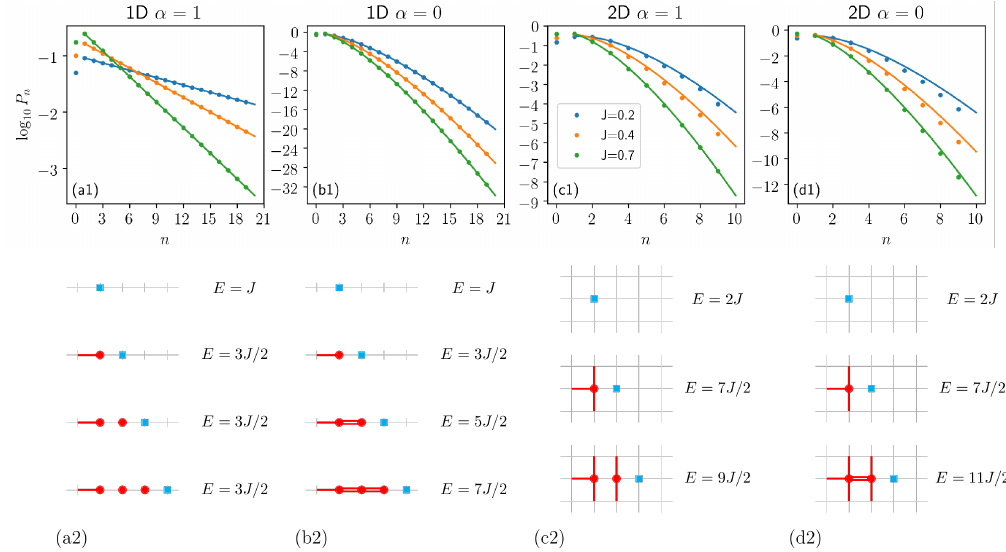
} of observing n magnons in the ground state of single hole Figure 1: Probabilities { P n wave function as calculated using the ME method for different values of J / t in the t – J model in the 1D case (a1) with and (b1) without magnon-magnon interactions; z and the 2D case (c1) with and (d1) without magnon-magnon interactions. In (a1) [ (b1) ] the curves are obtained analytically (see text); in (c1) [ (d1) ] the curves are fits to the numerical results (points) assuming the same functional dependence as in (b1), cf. Appendix A. The cartoons, (a2)–(d2), illustrate the differences